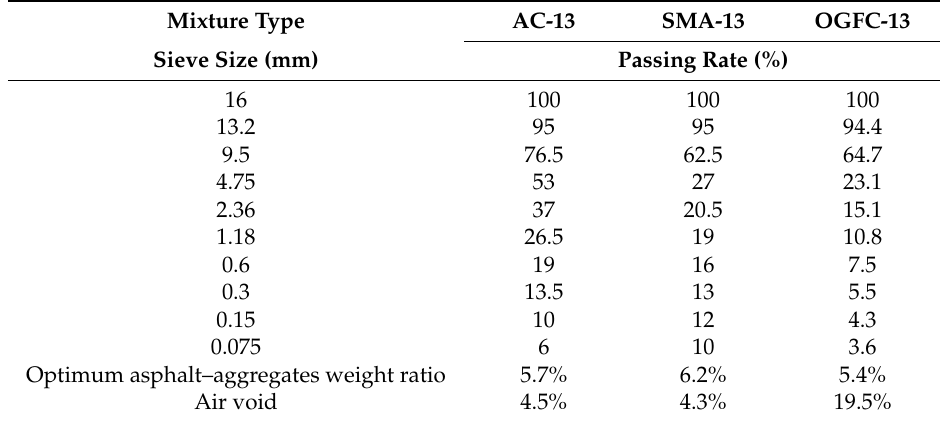
Figure 1. Chart of AC (Asphalt Concrete)-13, SMA (Stone Mastic Asphalt)-13, and OGFC (Open Graded Friction Course)-13 gradations. Table 1. Gradation and mix composition of asphalt mixtures.